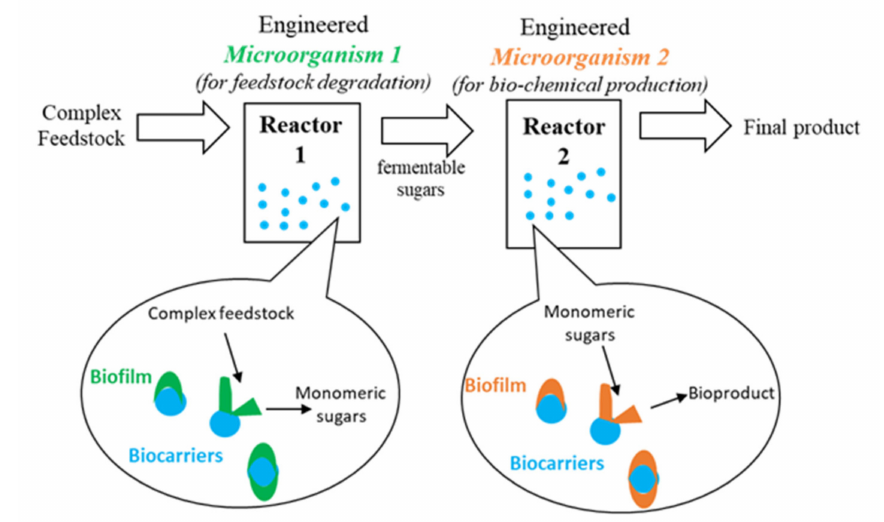
Figure 4. Sequential bioreactor